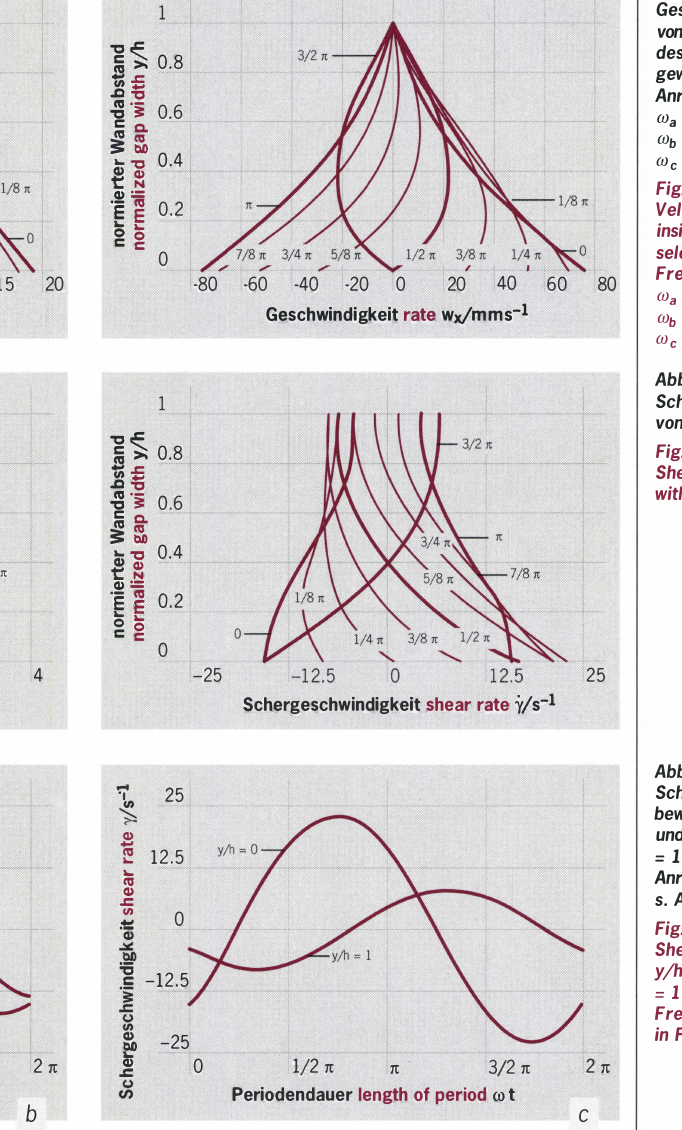
Fig. 2a-c: Velocity profile wx of glycerin inside the sheared gap at selected phase angles